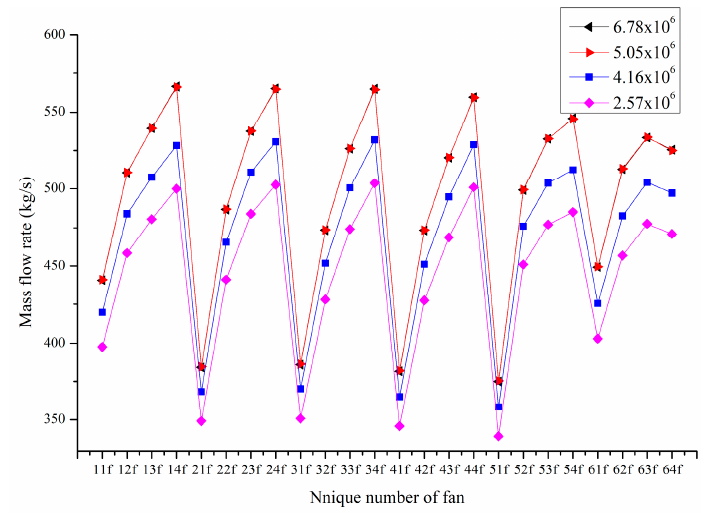
Figure 6. Air flow rate of fans at the crosswind of 4 m·s − 1 .